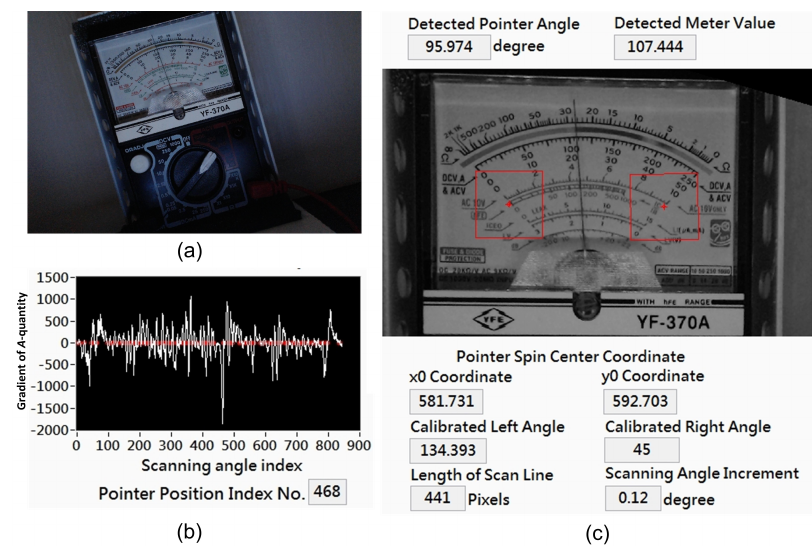
Figure 14. ( a ) Low illumination image of the rotated A-meter measuring 110 Vac line power with the function “ACV 250” selected. ( b ) Its GA -profile. ( c ) The detection results displayed on the LabVIEW interface that was used to perform our algorithms. Note here that there was a slightly tilted situation in this test. Even the A-meter was rotated 15.947 ◦ and the illumination was low with ¯ I = 49.8. Tthe result ( V p = 107.444 Vac) obtained by the proposed method is very close to the V h = 108 Vac observed by the human eye.